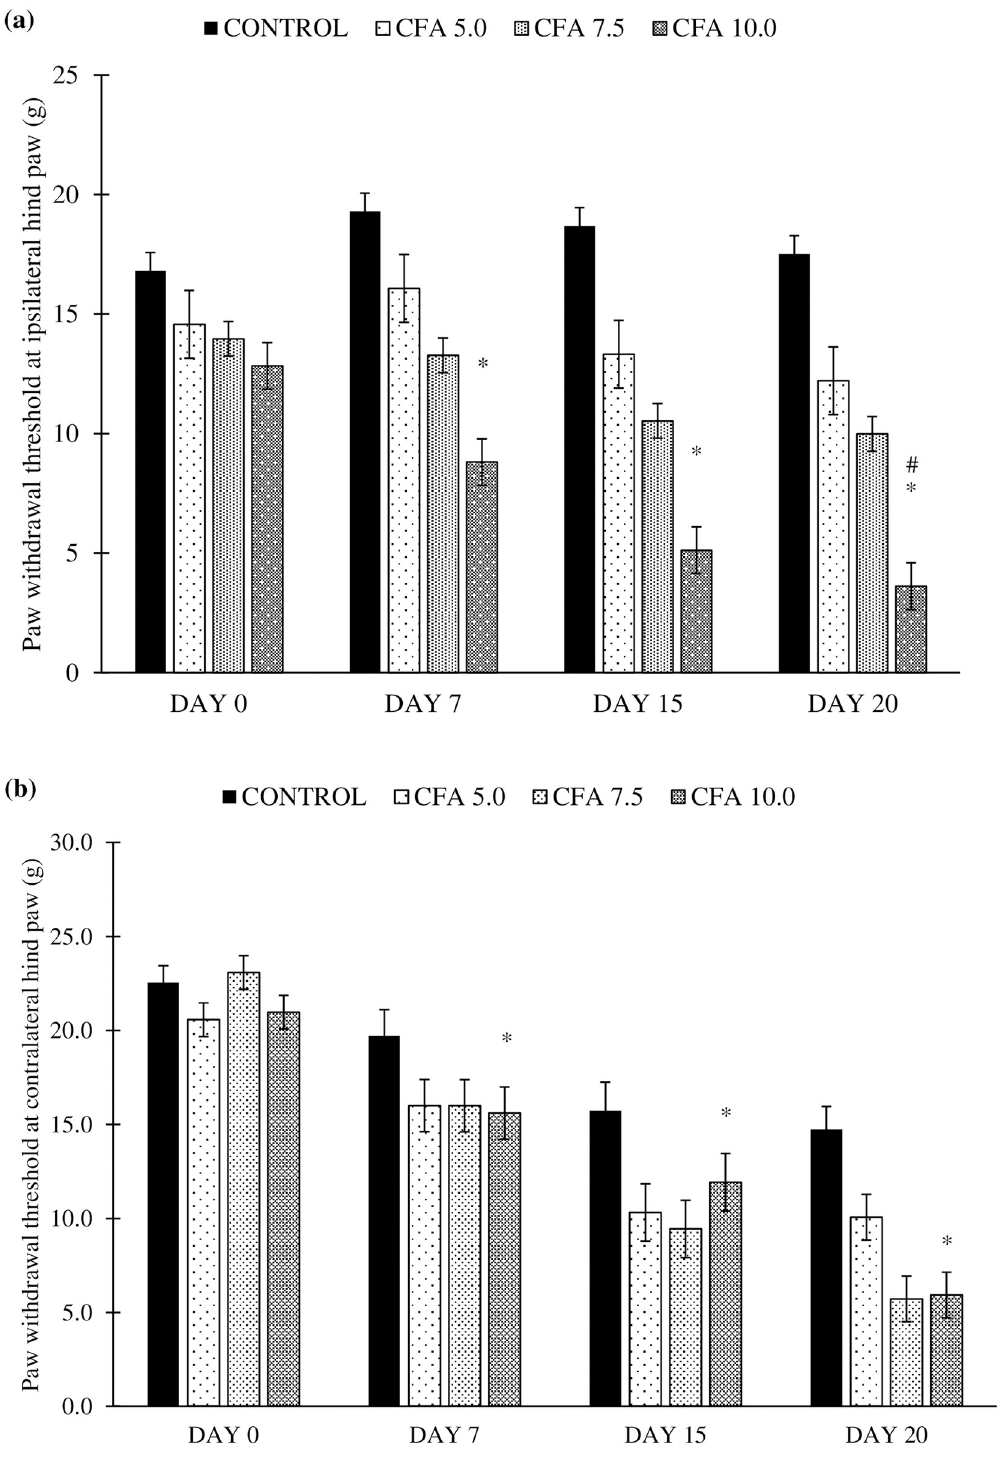
Fig 4. Paw withdrawal threshold at the (a) ipsilateral (CFA-inoculated) hind paw and (b) contralateral (non-CFA- inoculated) hind paw in the treatment groups on day 0, 7, 15 and 20 (n = 6). The values are presented as mean ± standard error of the mean (SEM). � p < 0.05 Statistical comparison to control group and # p < 0.05 Statistical comparison to CFA 7.5. CFA 10.0 group showed a consistent significant reduction in paw withdrawal threshold compared to the control group, indicating the development of tactile allodynia in the rat, beginning with the ipsilateral followed by contralateral hind paws.